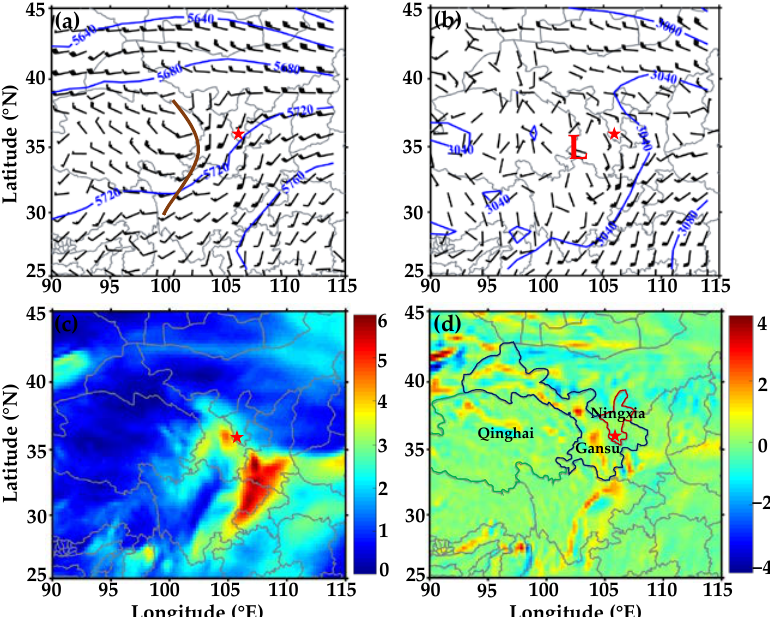
Figure 2. Weather charts at 0000 (UTC) on 14 August 2020 show ( a ) 500 hPa and ( b ) 700 hPa geopotential heights (blue line, unit: dagpm), horizontal winds (vector bar), and ( c , d ) represent integrated water vapor flux (10 5 g·m −1 ·s −1 ) and 700 hPa relative vorticity (10 −4 s −1 ), respectively. The red pentagram denotes the location of the Liupan Mountains.